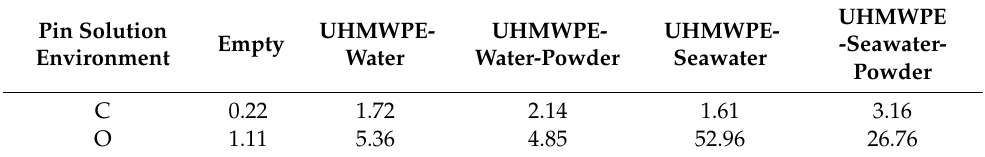
Figure 6. SEM images of wear marks on 1a90 aluminum plate matched with UHMWPE pins in solution with powder.